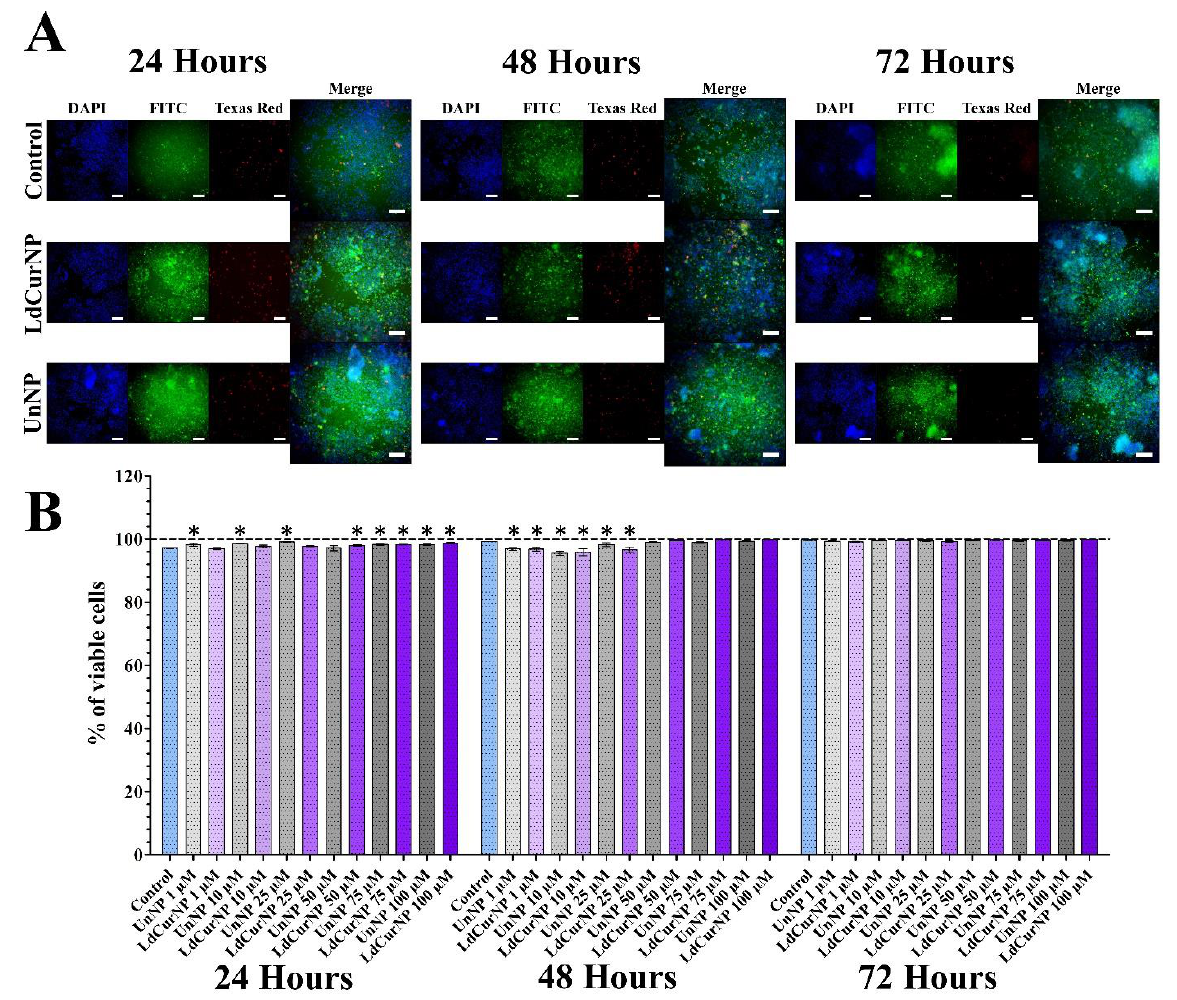
Figure 8. LIVE/DEAD viability assays of differentiated PC12 cells after 24, 48 and 72 h of incubation with the nanoparticles’ suspensions in different concentrations. ( A ) Representative images of control, L-DOPA, and Curcumin-loaded Nanoparticles (LdCurNP) 100 µM and Unloaded Nanoparticles (UnNP) 100 µM. Cells nuclei were stained with Hoechst 33342 and observed with the DAPI channel, live cells were stained with calcein and observed in the FITC channel, dead cells were stained with ethidium homodimer-1 and observed in the Texas Red channel. (Scale bar 100 µm). ( B ) LdCurNP and UnNP suspensions in concentration of 1, 10, 25, 50, 75 and 100 µM, Values were presented as mean ± standard error of the % of viable cells (* p < 0.05; n.s. p > 0.05).